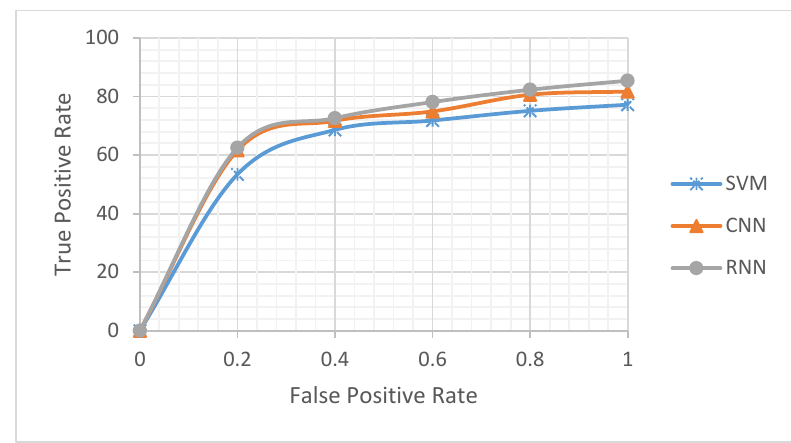
Figure 14. Area under the ROC curve on LC5 dataset with (area = 0.71).